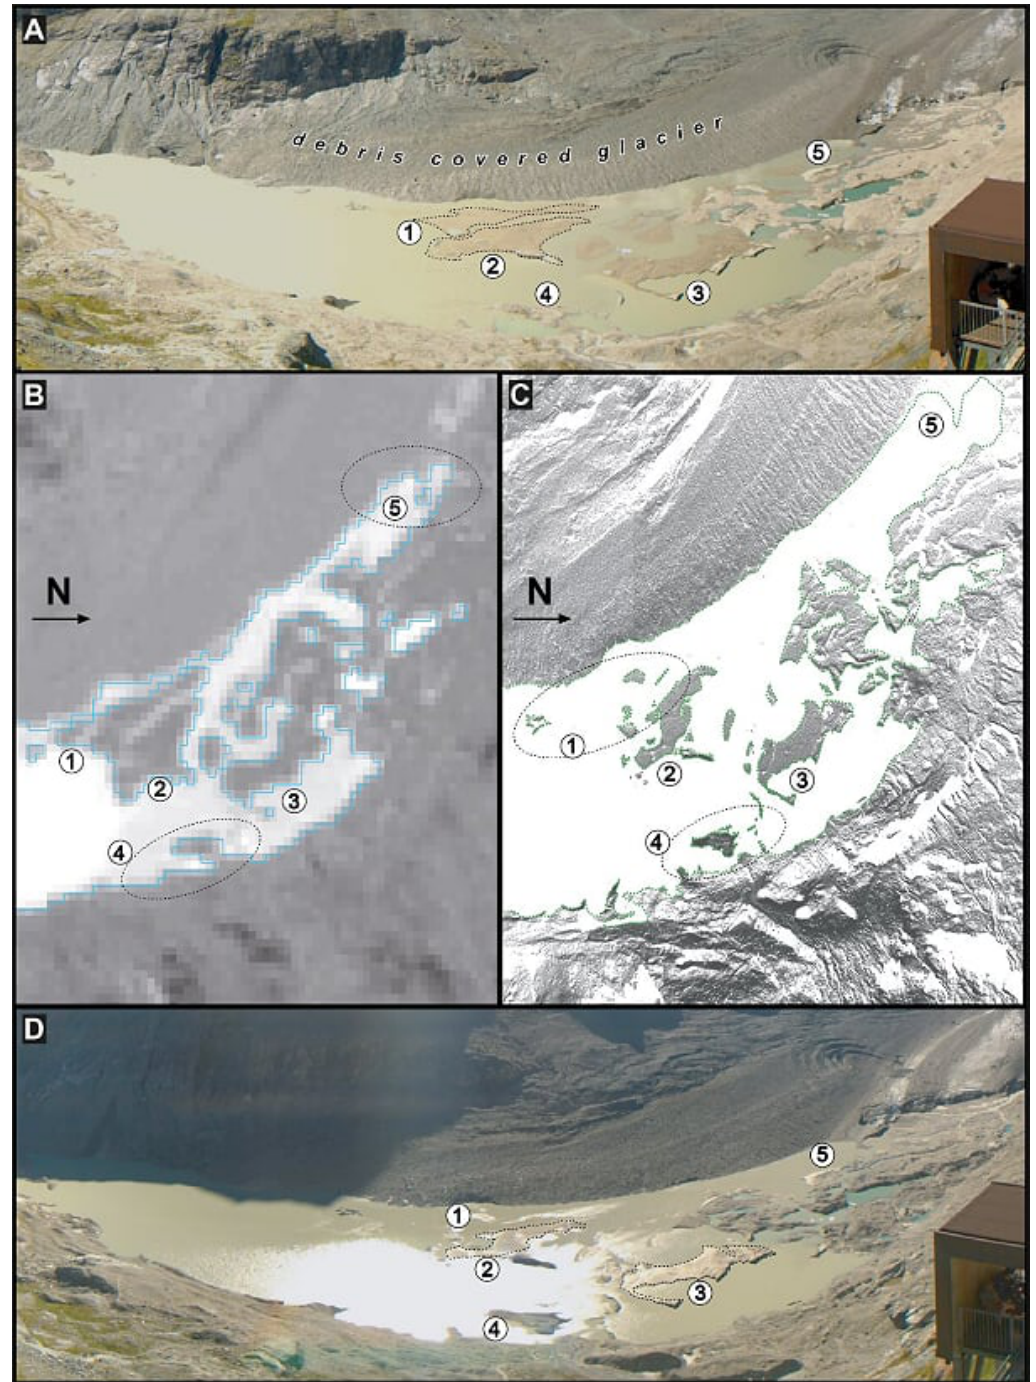
Figure 4. Comparison of glacier lake delineation and different data basis on 2016-08-27: ( A ) automatic Camera at 12:15; ( B ): automatic glacier lake delineation based on Sentinel-2 data at 12:10 using NDWI classification (threshold); ( C ) manuel glacier lake delineation based on point cloud TLS data at 17:00; and ( D ) automatic Camera at 16:25. Codes for areas of interest: 1–3, dead-ice/sander island; 4, dead-ice island/peninsula; 5, glacier terminus